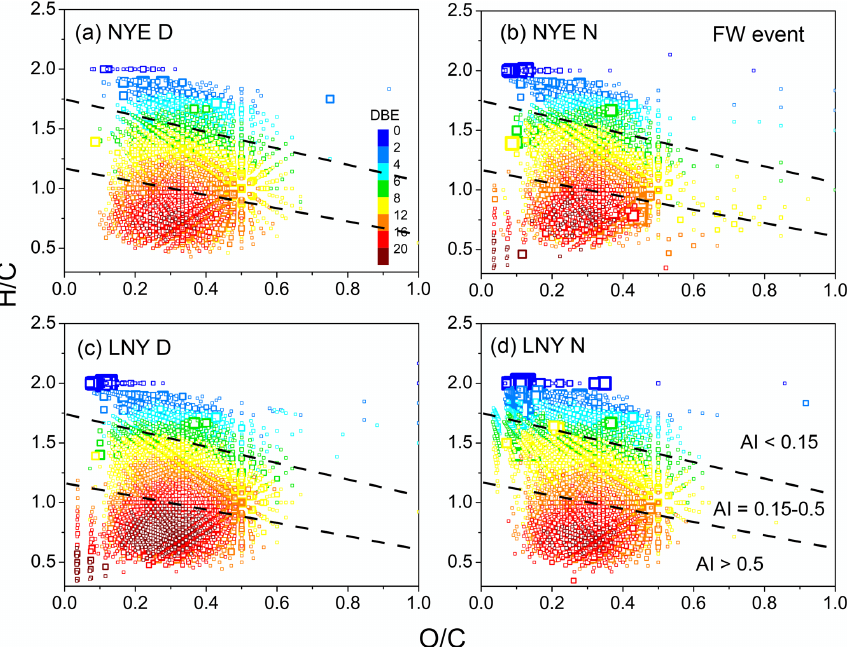
Figure 5. Van Krevelen diagrams (the H / C via O / C ratios) for the CHO compounds with various aromatic index (AI) value ranges. The dashed lines separate the different AI regions. The size of the symbols reflects the relative peak intensities of compounds on a logarithmic